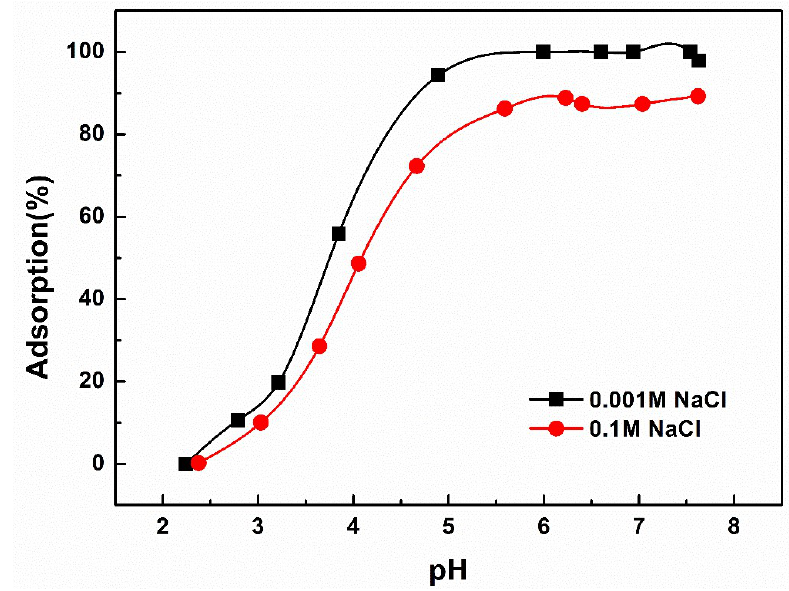
Figure 6. E ff ects of ionic strength on U(VI) ions adsorption at m / V = 0.6 g / L and pH = 3.6 ± Figure 6. Effects of ionic strength on U(VI) ions adsorption at m/V = 0.6 g/L and pH = 3.6 ± 0.05.